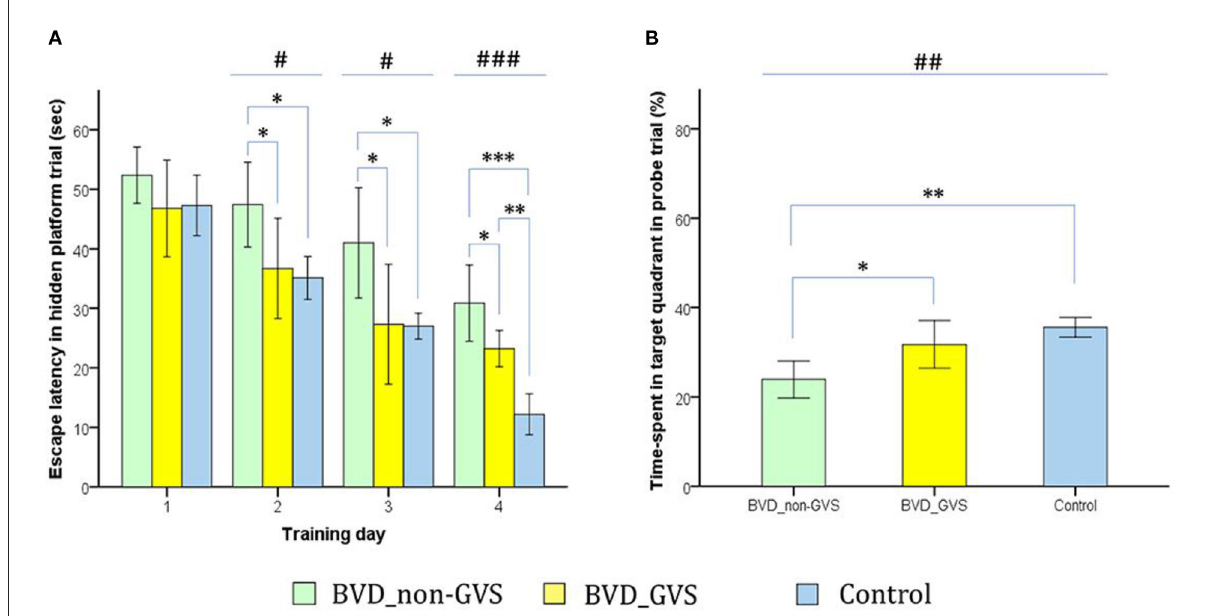
FIGURE5 Evaluation of long-term spatial reference memory using the Morris water maze (MWM). The escape latencies to find the hidden platform gradually decreased through the training sessions, indicating ongoing learning. Longer values of escape latency to find the hidden platform indicate an inadequate acquisition of spatial memory and navigation. Differences between the groups were observed on training days (TDs) 2 ( p = 0 .012, ANOVA), 3 ( p = 0 .013, ANOVA), and 4 ( p < 0 .001, ANOVA). The BVD non-GVS group had longer escape latency than the control group on TDs 2 ( p = 0.022, Bonferroni test), 3 ( p = 0.032, Bonferroni test), and 4 ( p < 0.001, Bonferroni test). The BVD GVS group had shorter escape latency than the BVD non-GVS group on TDs 2 ( p = 0.037, Bonferroni test), 3 ( p = 0.028, Bonferroni test), and 4 ( p = 0.024, Bonferroni test) (A) . Residual impairments in long-term spatial memory were also indicated by a lower percentage of time spent in the target quadrant (probe trial) on POD 14 in the BVD non-GVS compared with both the control ( p = 0.001, Bonferroni test) and BVD GVS groups ( p = 0.012, Bonferroni test) ( p = 0.001, ANOVA) (B) . The values are indicated as the mean ± SD. Statistical significance was calculated using one-way ANOVA with post-hoc tests. *Significant differences between two groups; # Significant differences among three groups: * , # p < 0.05; ** , ## p < 0.01; *** , ### p < 0.001. Reproduced from Nguyen et al.